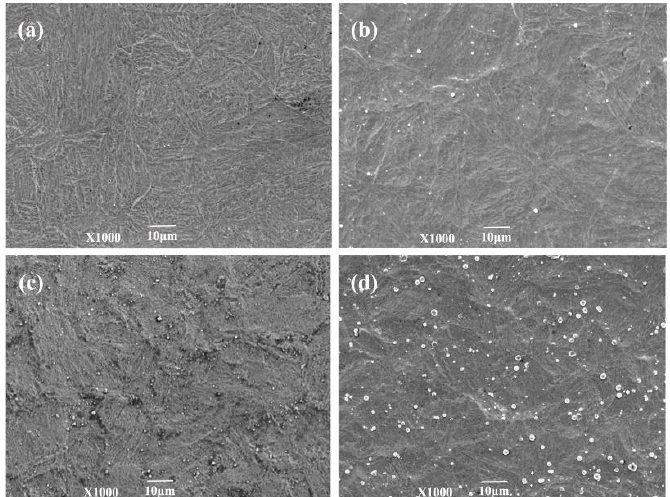
Figure 6. Surface morphology of two stainless steels after ion nitriding treatment: ( a ) 300 °C for 24 h (1Cr15); ( b ) 300 °C for 48 h (1Cr15); ( c ) 300 °C for 24 h (17-4PH); ( d ) 300° C for 48 h (17-4PH). Table 5. EDS data of nitrided layer surface (wt.%) .